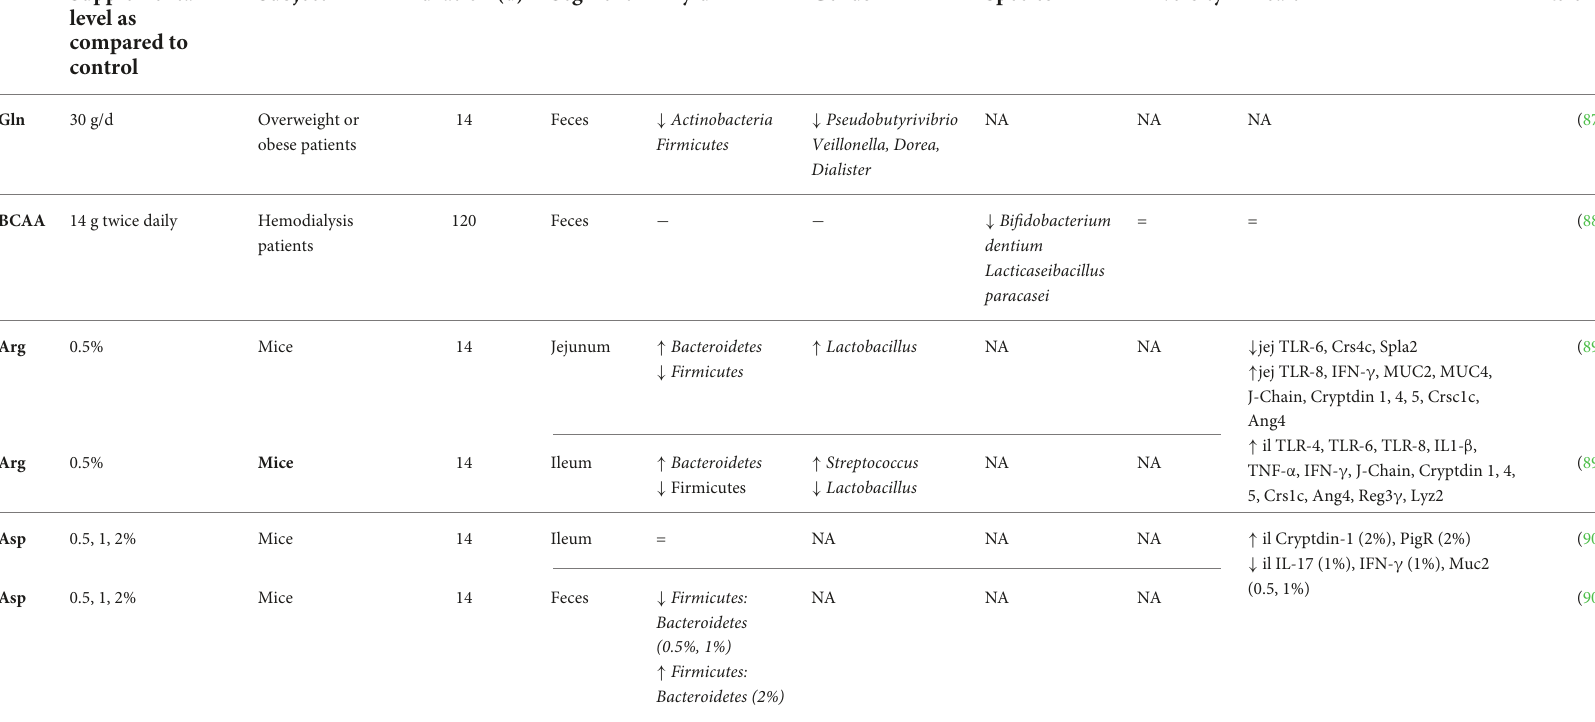
TABLE 2 Effect of free amino acid supplementation on microbiota and health outcomes in humans and